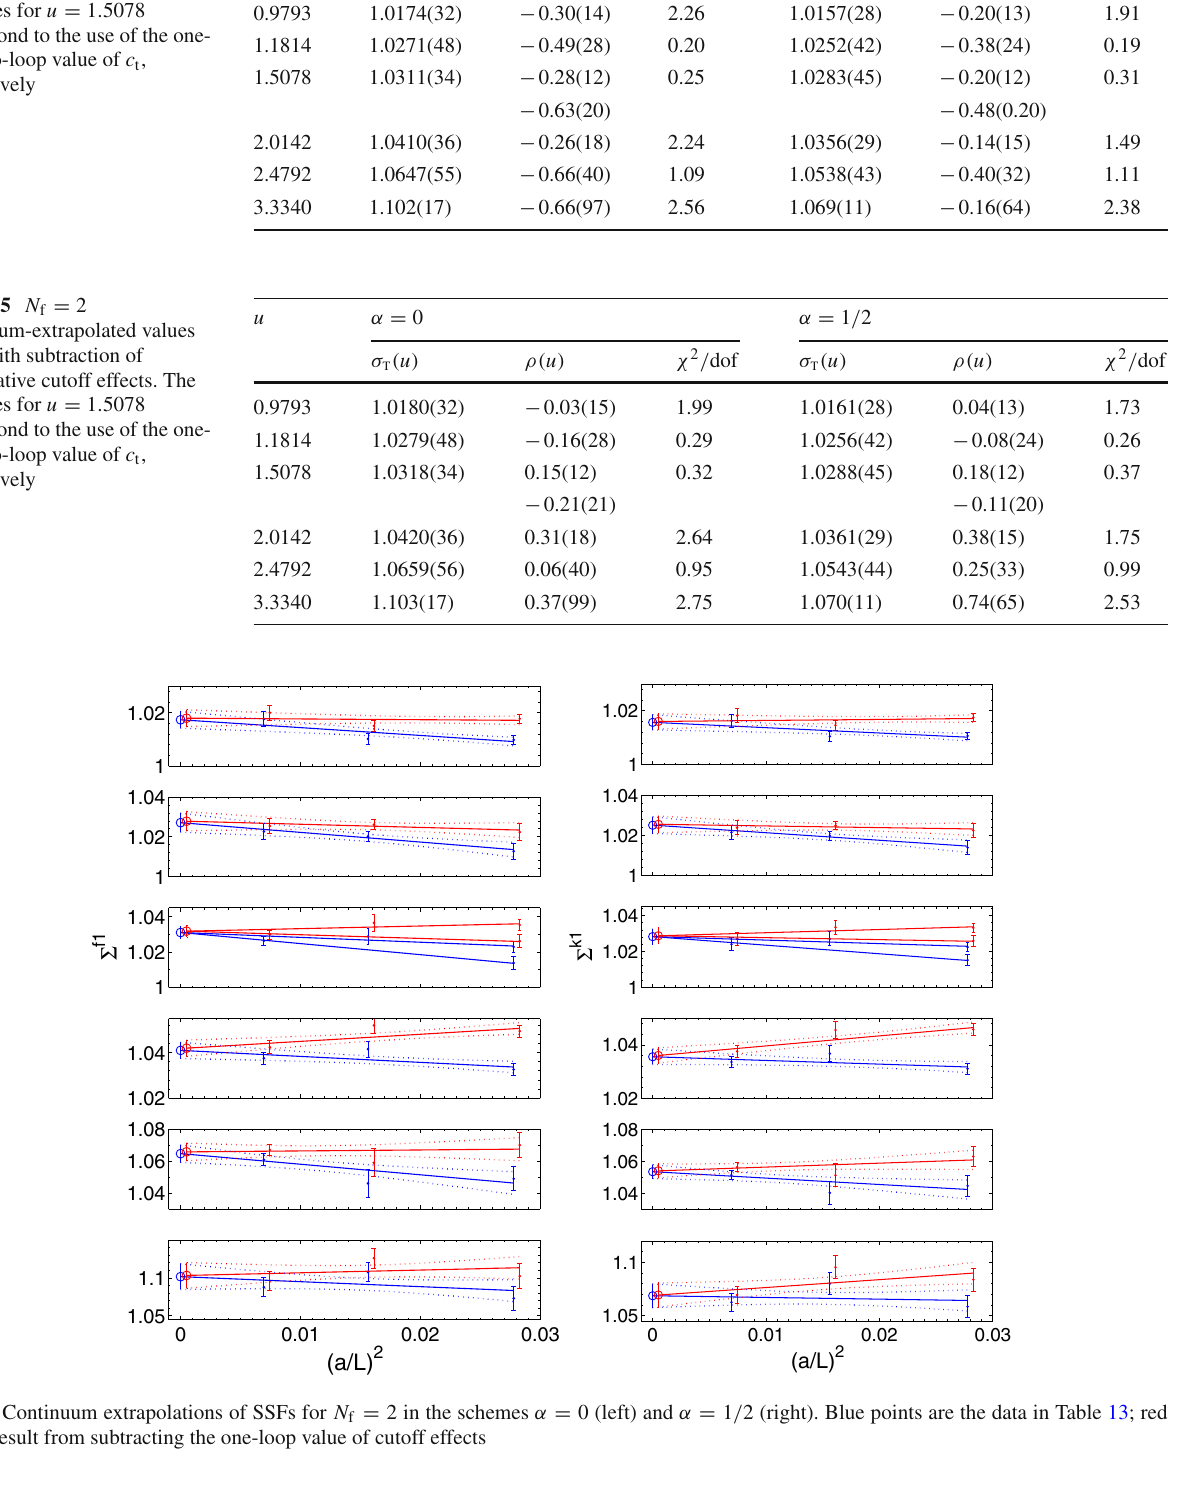
continuum-extrapolated values of σ T without subtraction of perturbative cutoff effects. The two lines for u = 1 . 5078 correspond to the use of the one- and two-loop value of c t , respectively